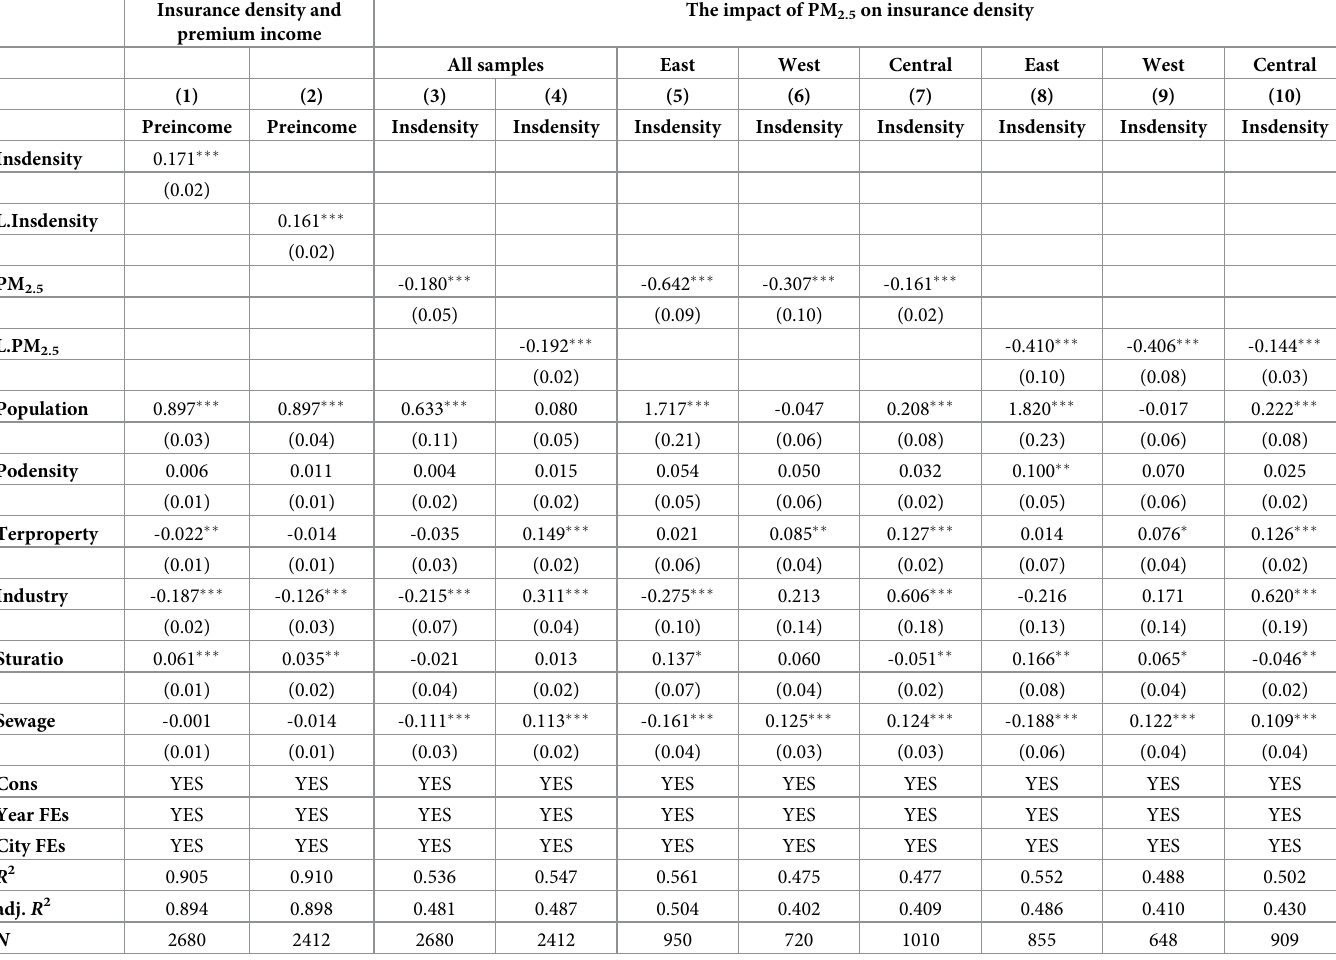
The impact of PM 2.5 on insurance